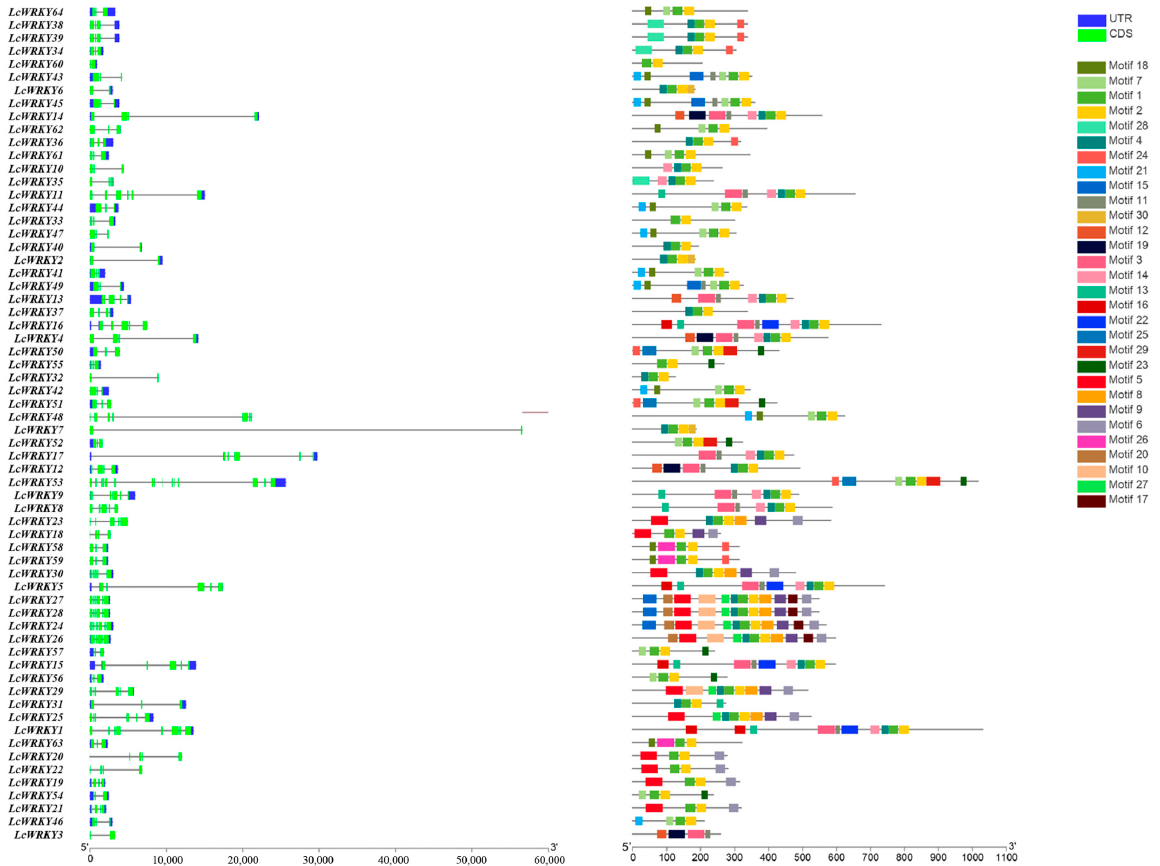
Figure 1. Gene structure and motif analysis of LcWRKYs . The blue boxes, green boxes, and thin black lines represent the UTR, CDS, and introns, respectively. MEME analysis revealed conserved motifs of LcWRKY proteins. Colored boxes on the right denote 30 motifs.